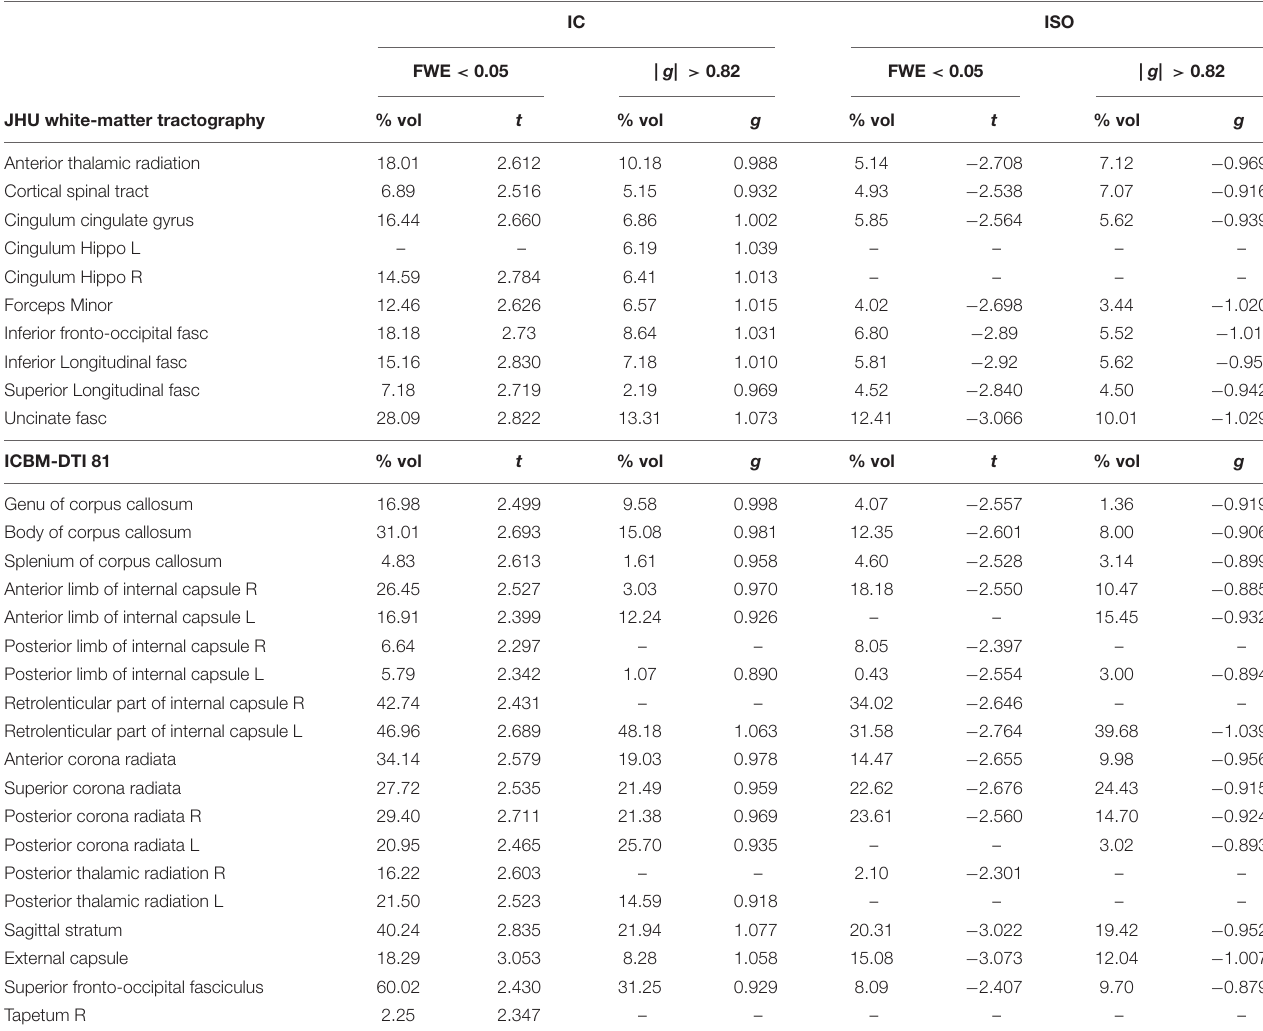
TABLE 2 | Significant clusters for IC and ISO with FWE < 0.05 and | g | > 0.82. IC ISO FWE < 0.05 | g | > 0.82 FWE <